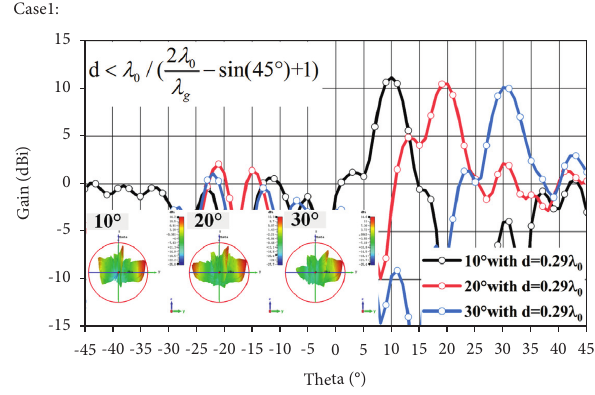
Figure 4: Antenna pattern of DMA with d � 0 . 29 λ